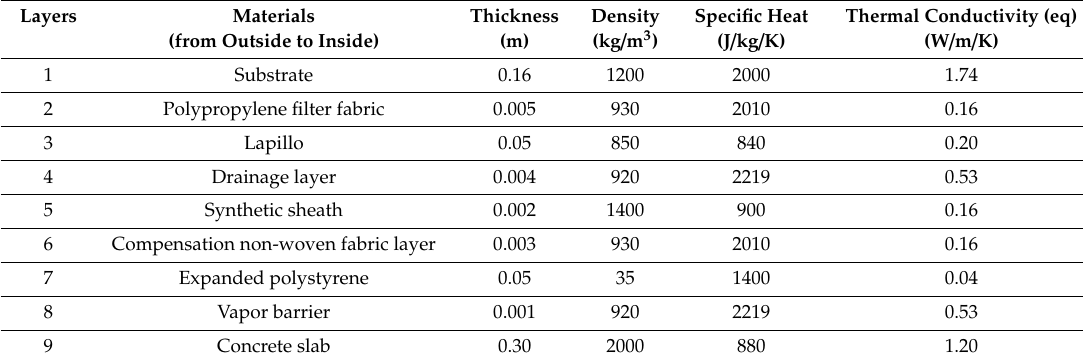
Table 7. Stratigraphy of the intensive thin (thickness: 0.58 cm) green